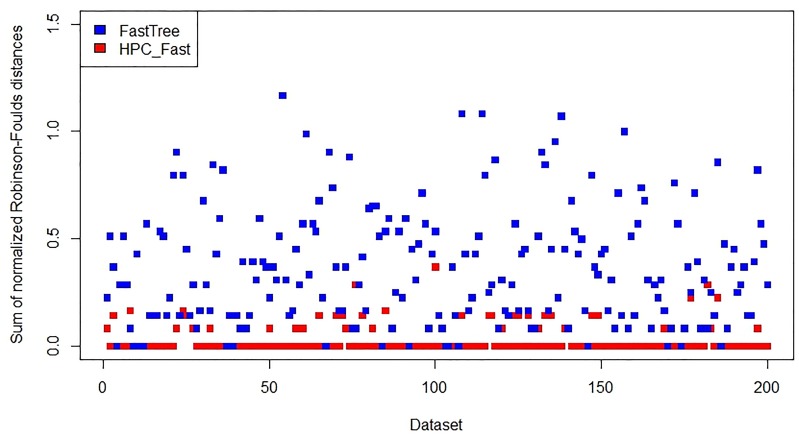
Accuracy assessment of FastTree and HPCFast on 200 Narrow datasets.